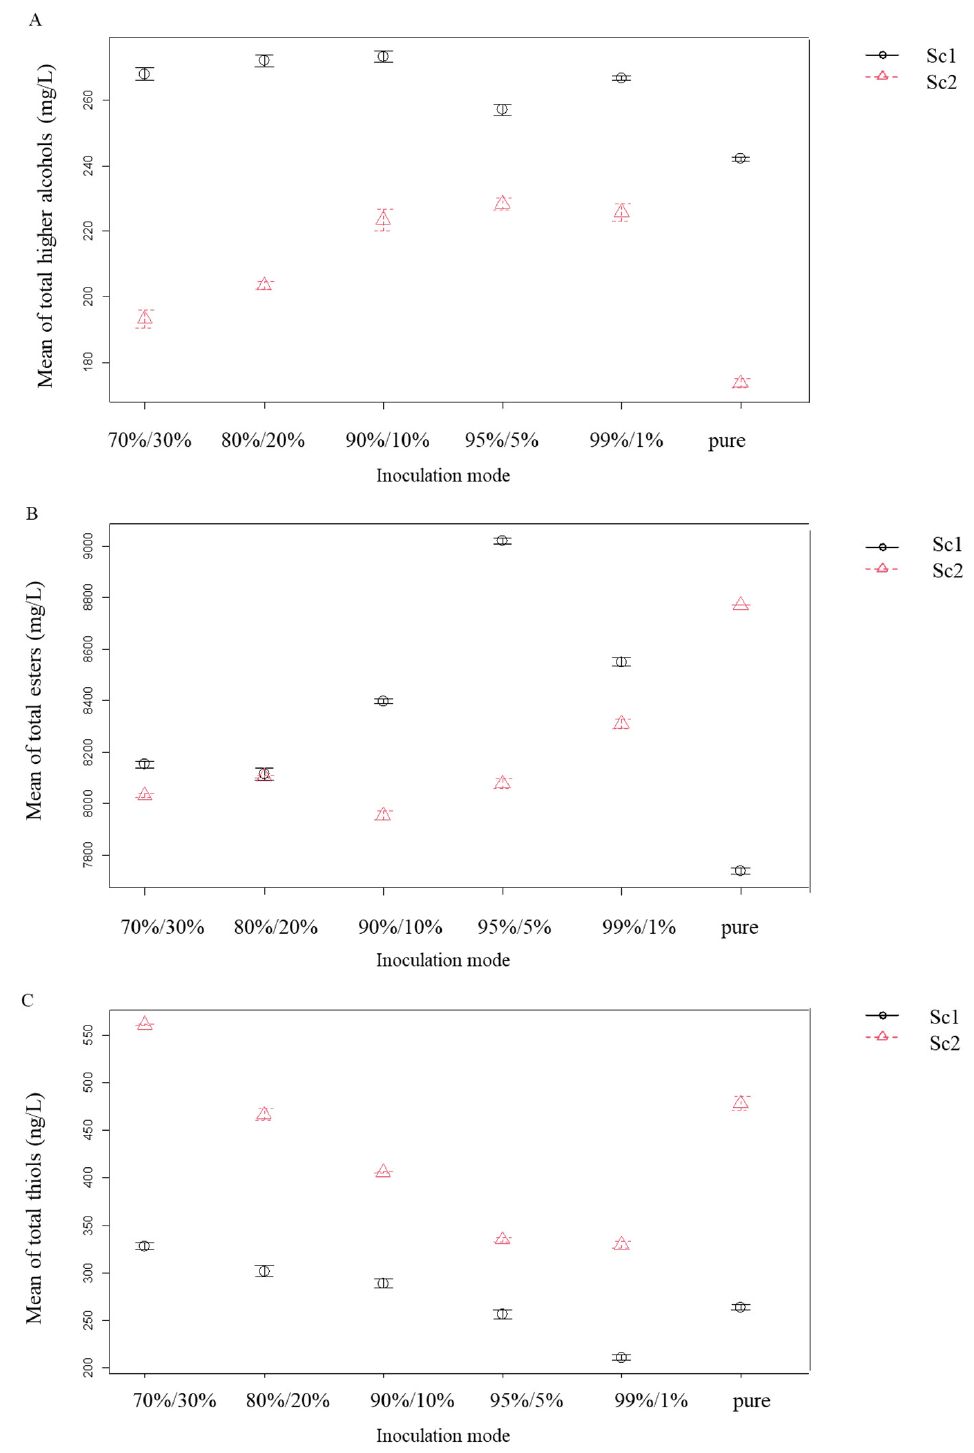
Figure 2. Interaction plot of means of aromatic compounds versus inoculation mode for S. cerevisiae strains Sc1 and Sc2. The compounds belonged to the group of: ( A ) Higher alcohols, ( B ) Esters, and ( C ) Thiols. The inoculation mode concerned the pure cultures of Sc1 and Sc2 and the mixed cultures of the two S. cerevisiae strains Sc1 and Sc2 with the S. pastorianus strain Sp2 under different inoculation ratio Sp2/Sc strains (70%–30%, 80%–20%, 90%–10%, 95%–5% and 99%–1%). Error bars indicate the standard error of the mean values.